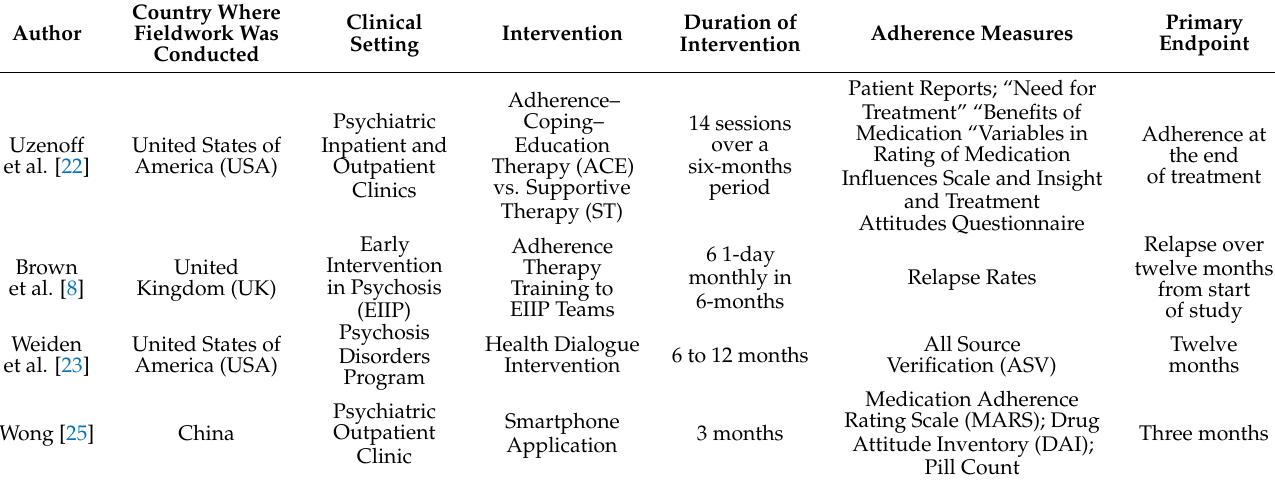
Table 1. Characteristics of included studies.